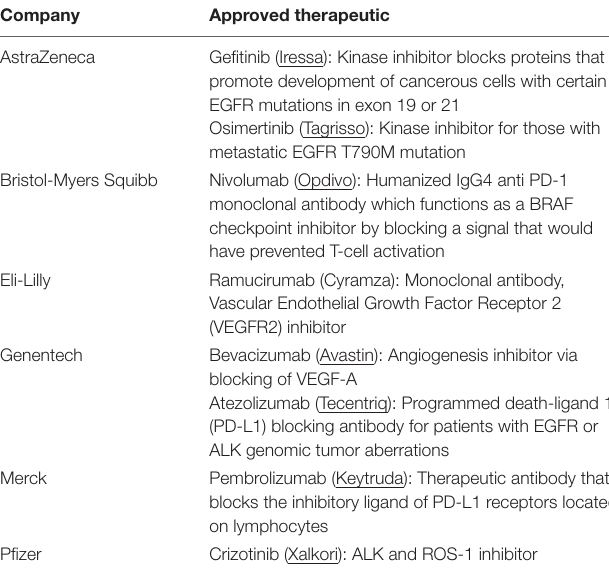
TABLE 1 | Sampling of FDA approved therapies for